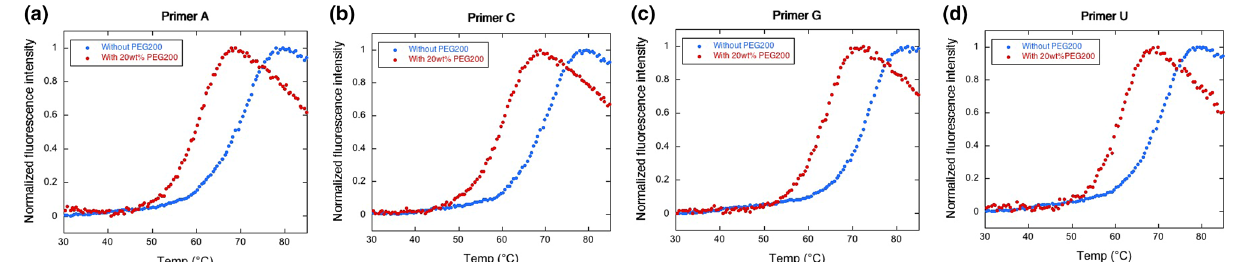
Figure 3. Fluorescence melting of the RNA duplexes composed with template strand and ( a ) primer A, ( b ) primer C, ( c ) primer G, and ( d ) primer U, respectively. The measurements were carried out in 200 nM each